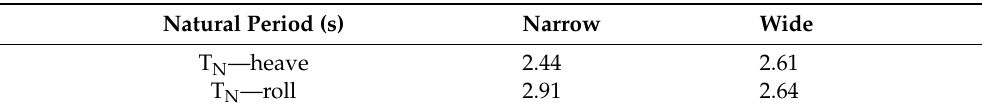
Table 4. Summary of Experimental Natural Period (prototype) in Heave and Roll for Both the Narrow and Wide Pontoons Constrained by Piles.